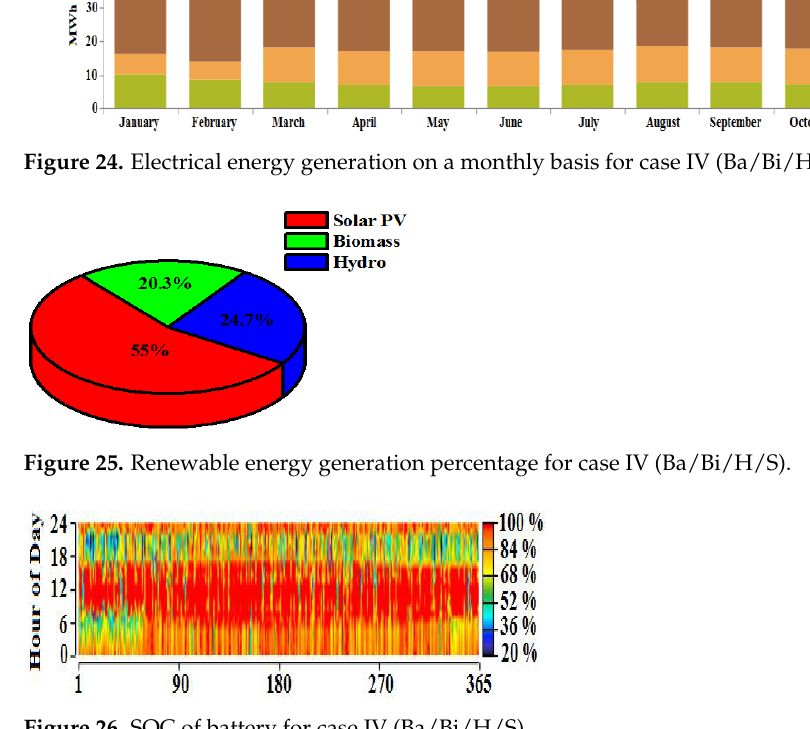
Figure 28. Total component cost breakdown for case IV (Ba/Bi/H/S).